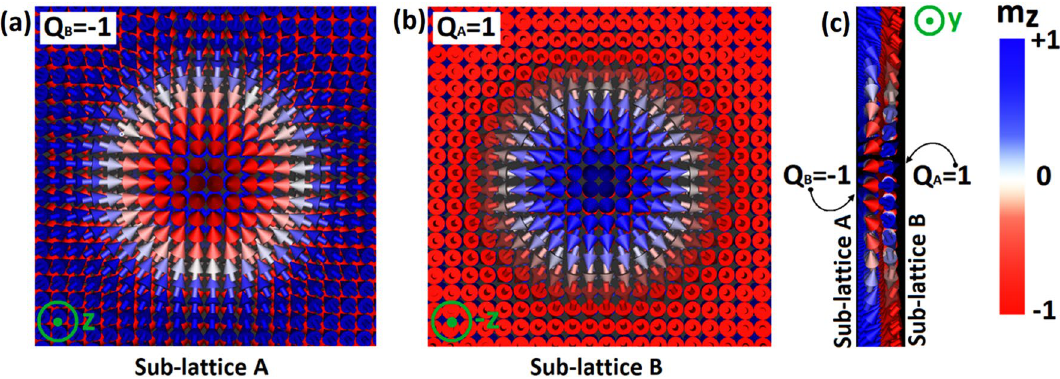
Figure 1. Top view of two sub-lattices (A) and (B) in an AFM monolayer within AFM skyrmion defined with opposite skyrmion numbers ( a ) Q A monolayer sliced along the y-axis into the skyrmion